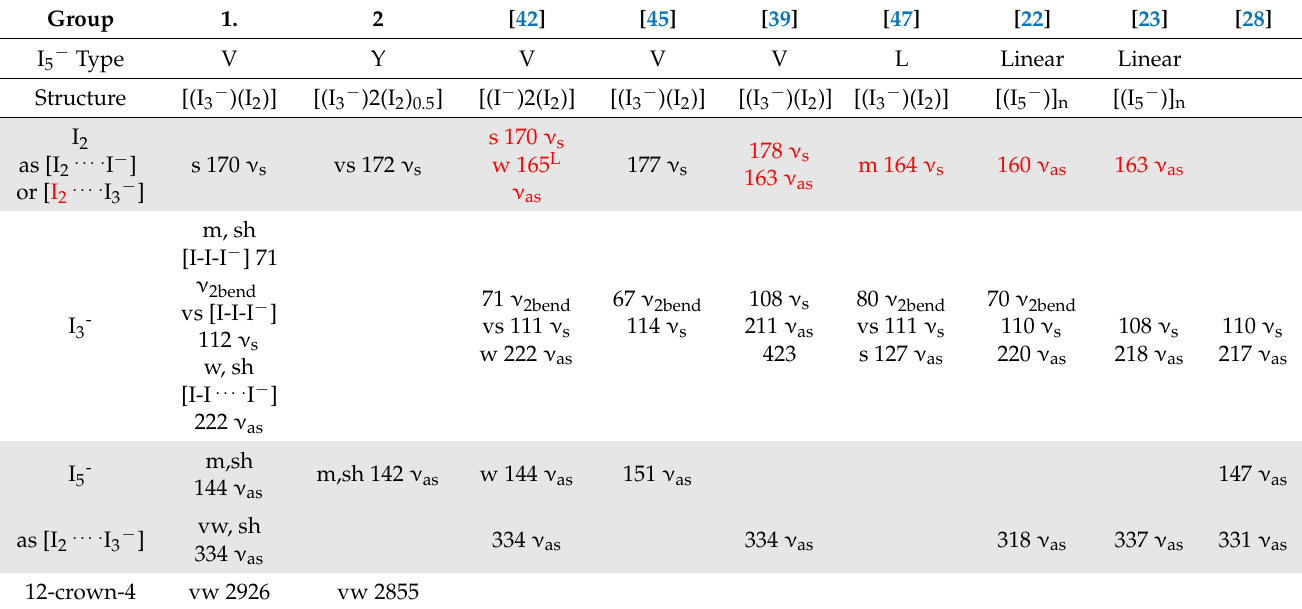
Table 2. The Raman shifts of iodine moieties in [Cu(12-crown-4) 2 ]I 5 (1), [Cu(H 2 O) 6 (12-crown-4) 5 ]I 6